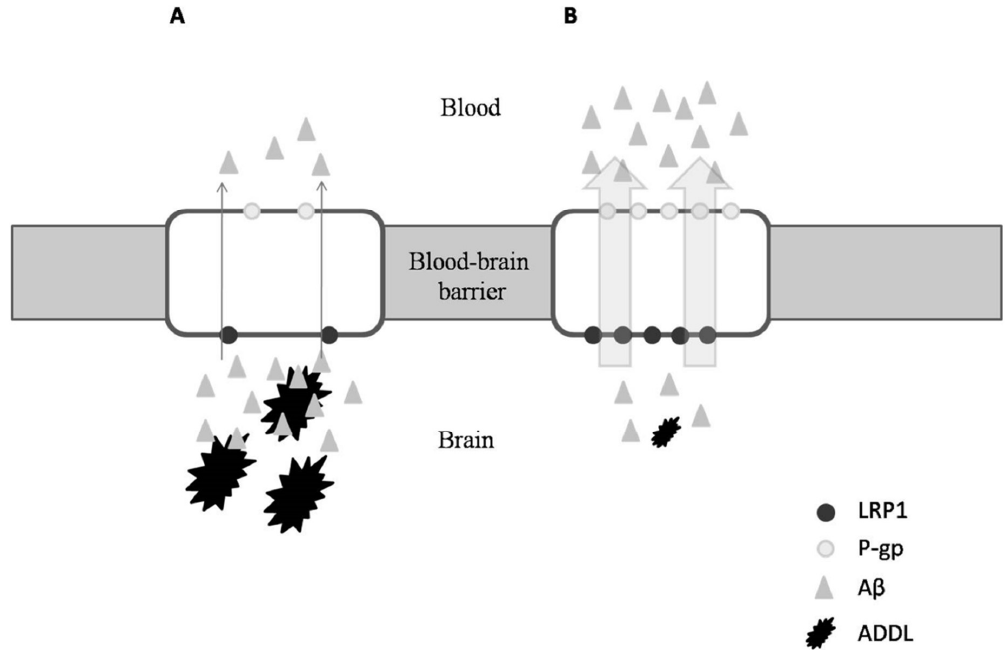
Figure 3. Transport of Aβ proteins through the blood–brain barrier under a situation of Alzheimer’s disease (AD) ( A ); after OC administration ( B ).